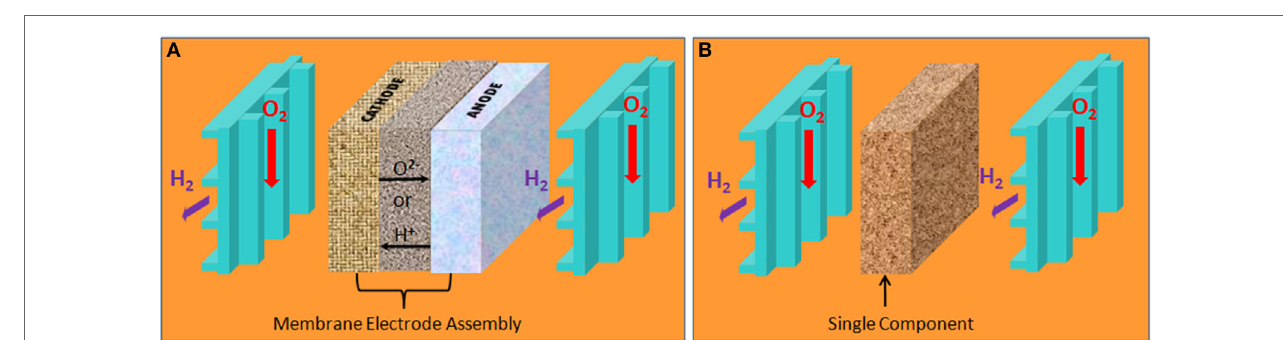
FiGURe 1 | Structures between (A) SOFC and (B) eFFC, or called single component